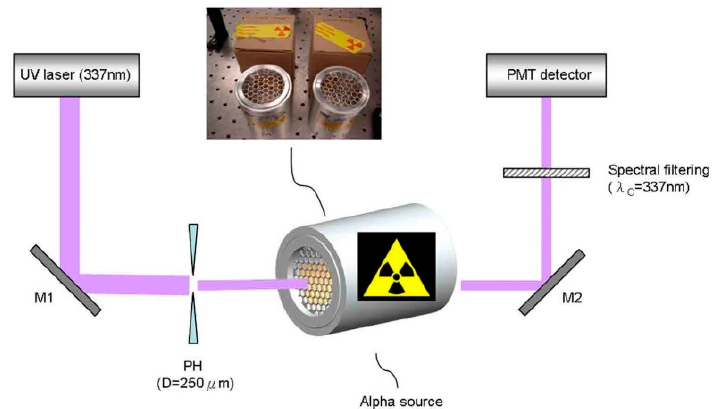
Figure 3. In this detection system, the α -particles released by the radioactive source are optically focused, filtered, photomultiplied, and electronically processed, and the information is collected by a computer system [79]. This figure is reprinted with the permission of AIP Publishing.